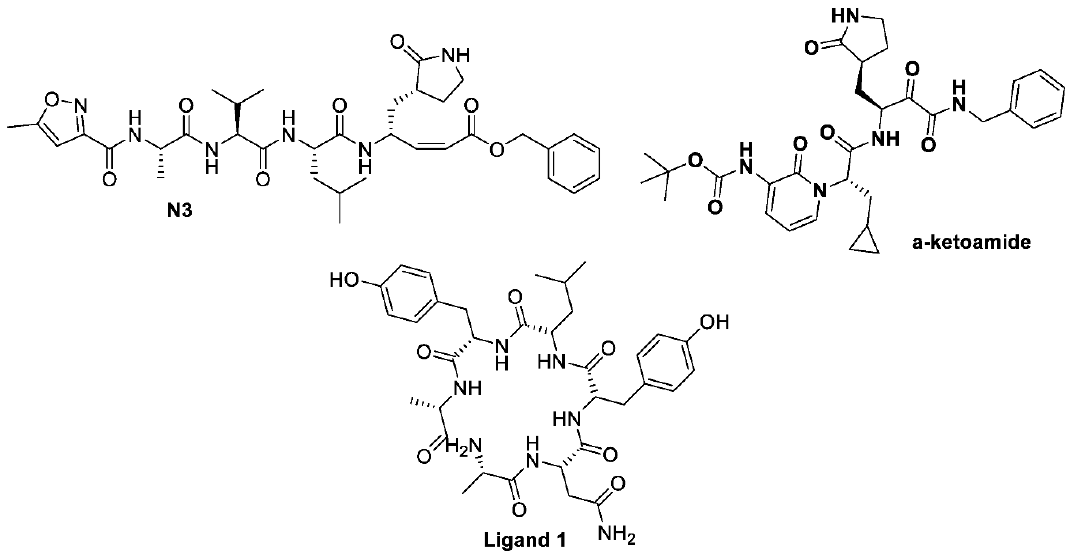
Figure 2. Chemical structure of ligands α -ketomaide and N3 for SARS-CoV-2 M pro (PDB ID: 6lu7, 6y2f), and Ligand 1 for SARS-CoV-2 spike glycoprotein (PDB ID: 6vsb). Docking with Spike Glycoprotein (PDB ID: Docking with M pro (PDB ID: 6lu7) of SARS-CoV-2